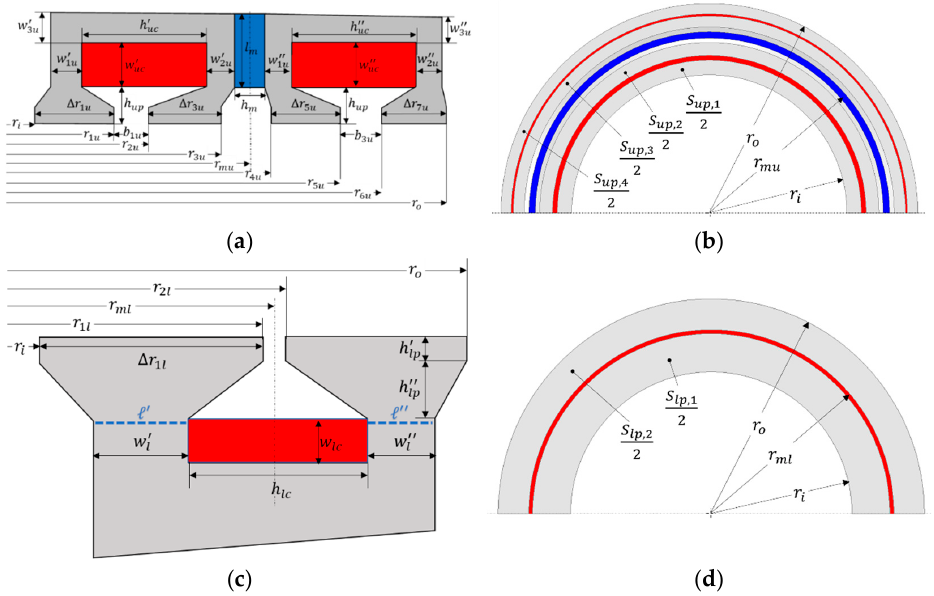
Figure 4. Geometric parametrization of the AHMB; ( a , b ): radial cross section and bottom view (half cross section) of the upper side; ( c , d ): radial cross section and top view (half cross section) of the lower side; (cid:96) (cid:48) , (cid:96) (cid:48)(cid:48) : lines for the sampling of the axial flux density.